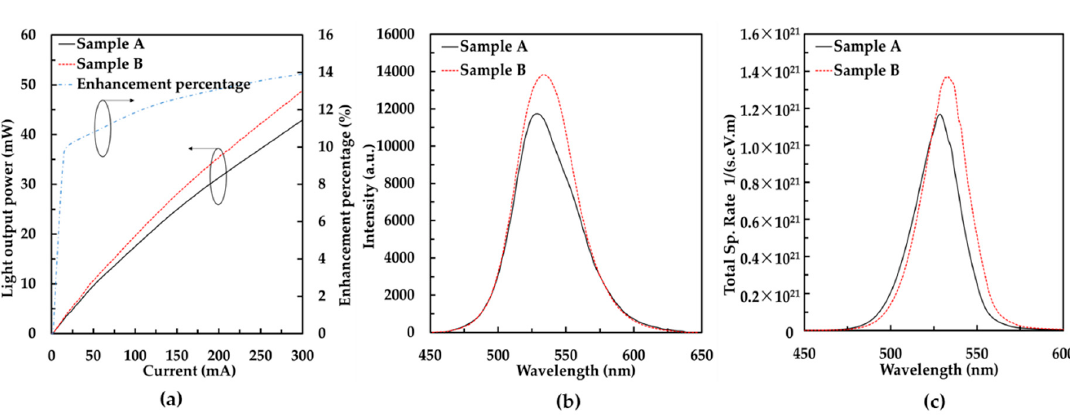
Figure 3. Light output properties of samples A and B: ( a ) measured light output power and enhancement percentage as a function of the injection current; ( b ) measured EL spectra at 300 mA; and ( c ) calculated EL spectra at 300 mA.